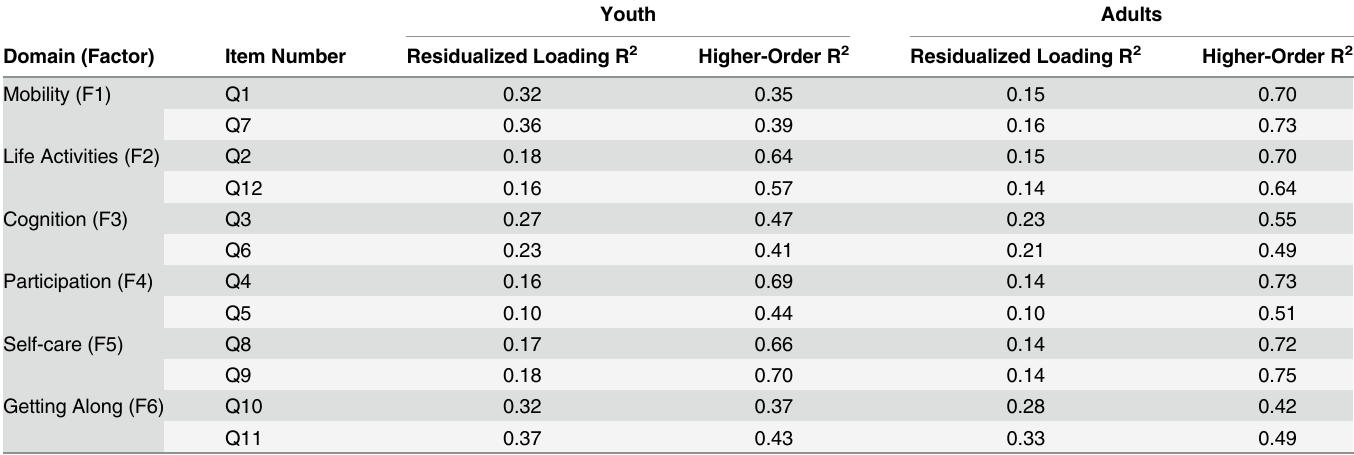
Table 5. Schmid-Leiman Transformation of WHODAS 2.0